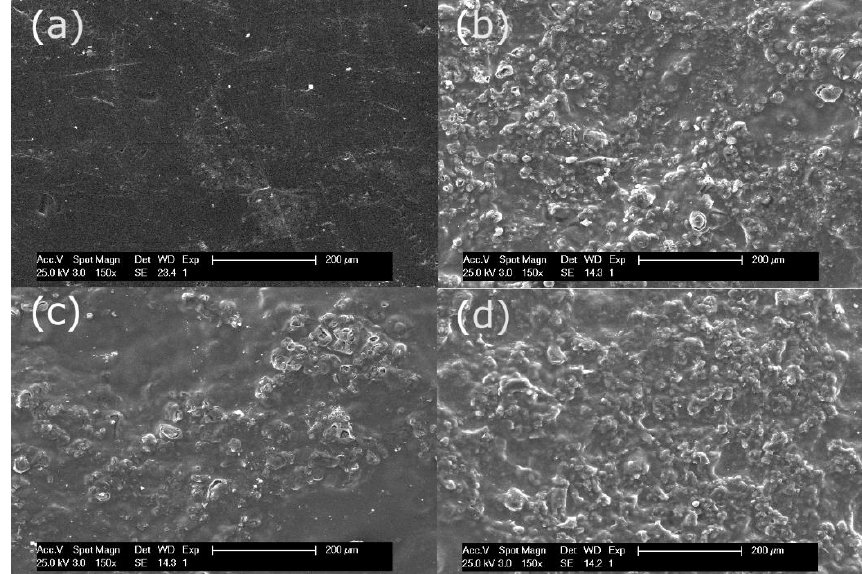
Figure 2. SEM surface micrographs of ( a ) Recycled ultrafiltration-like membrane (RE-UF), ( b ) Amb-RE-UF, ( c ) Puro-RE-UF and ( d ) Lew-RE-UF.